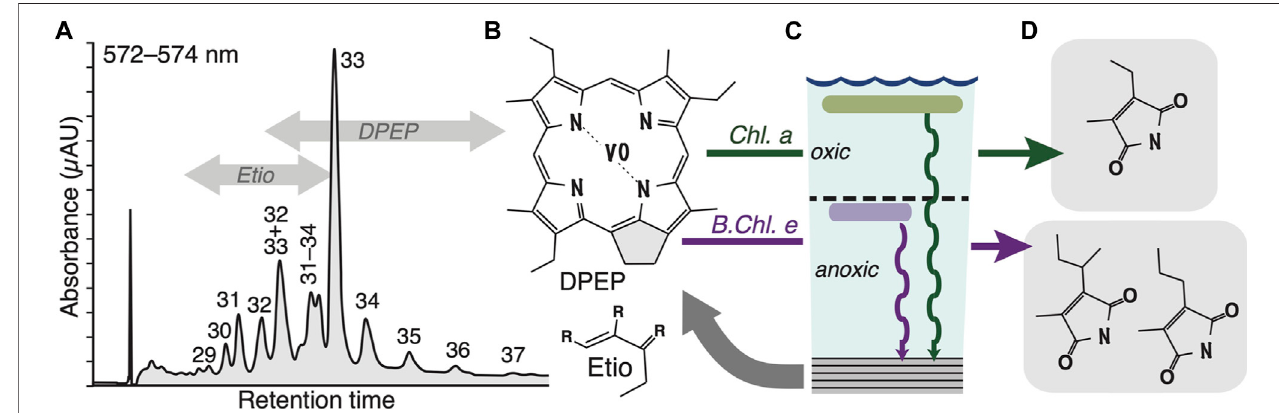
FIGURE 3 | Porphyrins and maleimides. Intact vanadyl porphyrins in SOSB sediments were characterized by LC-MS and quanti fi ed by UV vis spectrophotometry (A,B) . Chromatographic peaks in (a.) (sample OMR-11, Thuleilat Fm) are annotated by their corresponding carbon numbers. Porphyrins > C 32 indicate the presence of both chlorophyll-a and bacteriochlorophyll-derived structures that were biosynthesized in surface waters and at the chemocline, respectively (C) . Oxidation to maleimides (D) does not affect the characteristic alkylation pattern, allowing the distinction of maleimides primarily deriving from surface water chlorophyll-a (MEM) versus structures deriving from bacteriochlorophyll-c, -d or-e (MPM, MBM), produced by anoxygenic phototrophs.